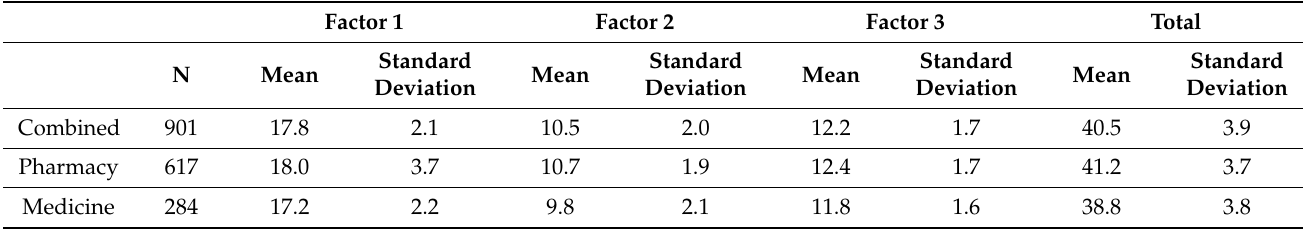
Table 4. Quantitative estimates of responses to